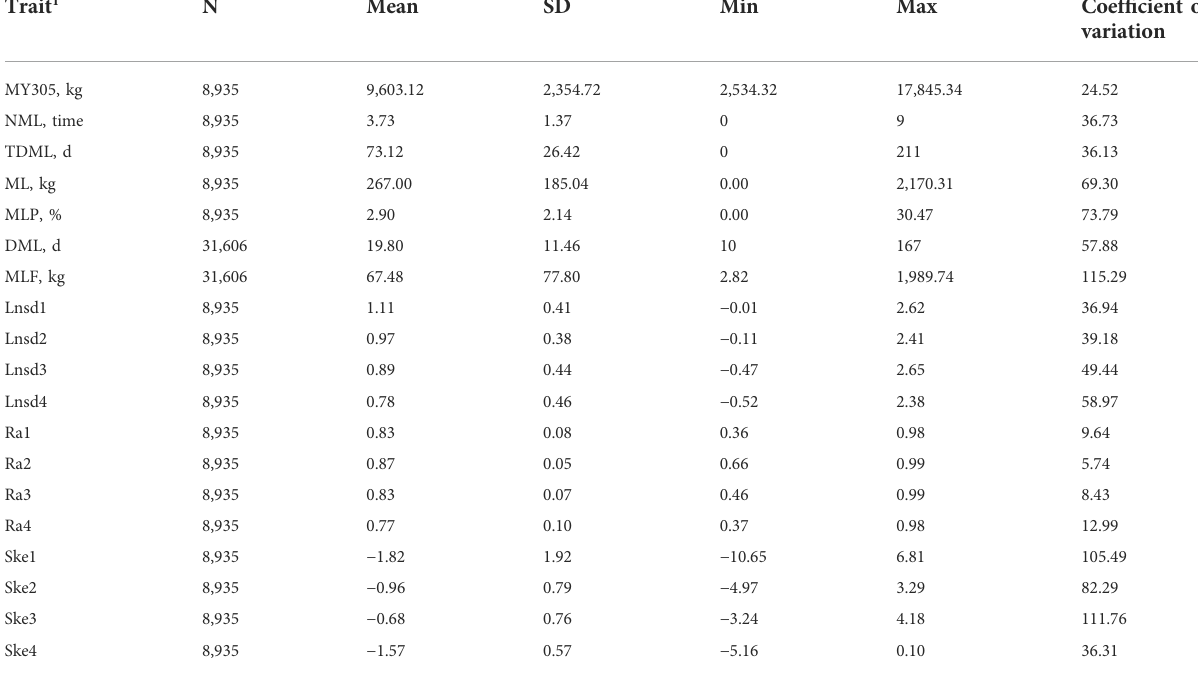
TABLE 1 Descriptive statistics of 305 days milk yield and resilience indicators in Chinese Holstein cattle.